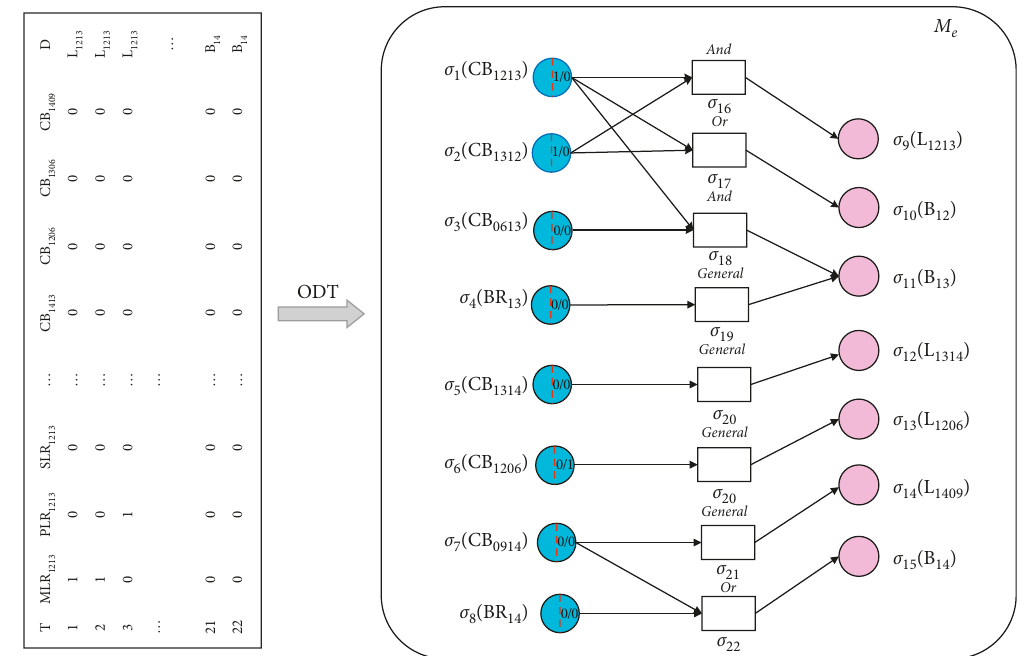
Figure 10: The srSNPS-based fault diagnosis model of S6.